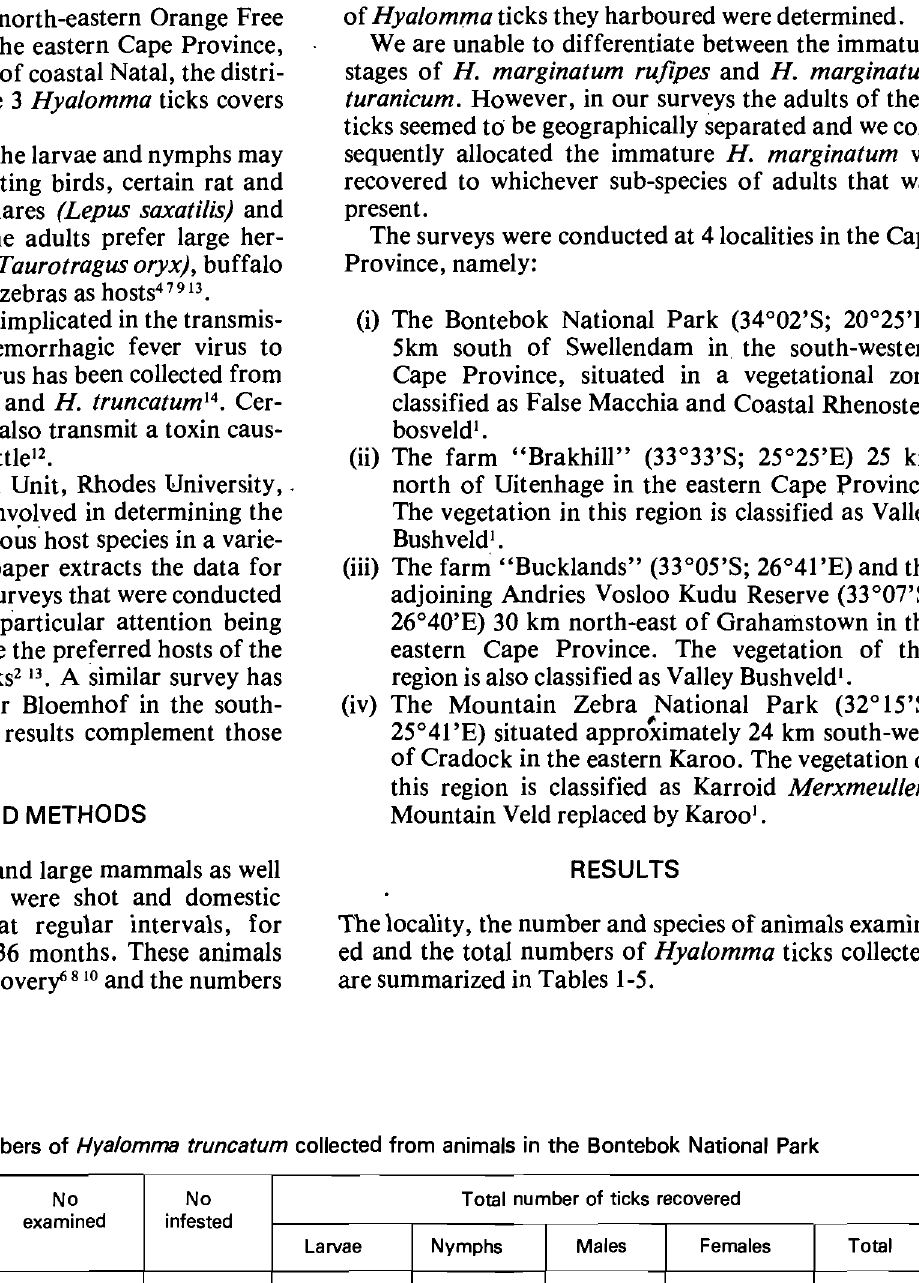
Table 1: Total numbers of Hyalomma truncatum collected from animals in the Bontebok National Park